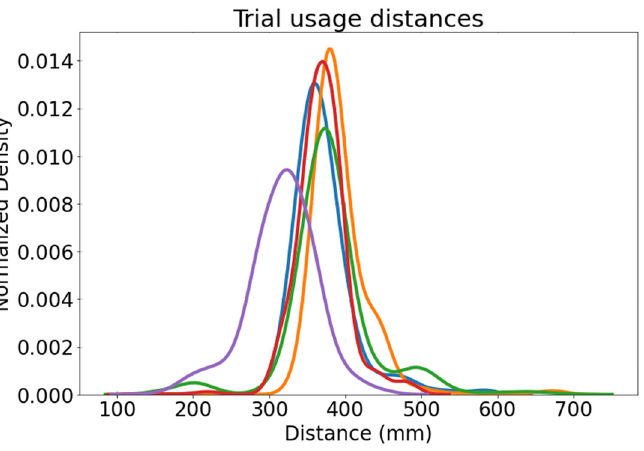
Figure 9. Evaluation of arm tracking using simple infrared markers, showing distribution for clinical operating distances from HoloLens 2 depth camera to patient’s arm, across multiple recordings.